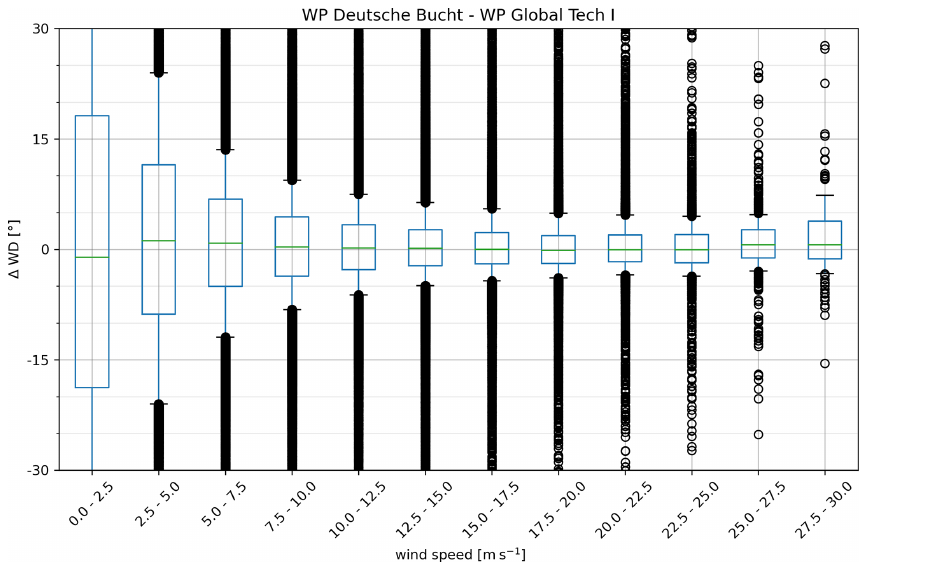
Figure 4. Wind direction changes between the locations of the wind farms Deutsche Bucht and Global Tech I (distance ≈ 44km inter-cluster scale) binned for the wind speed at the reference location (here: FINO1) obtained from 30 years of NEWA data (1989–2018). Green: median; blue box: quartiles; whiskers: 10% and 90% percentiles; circles: outliers.